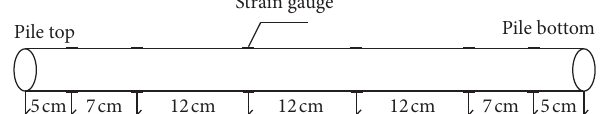
Table 2: Scaling law of laboratory model test.